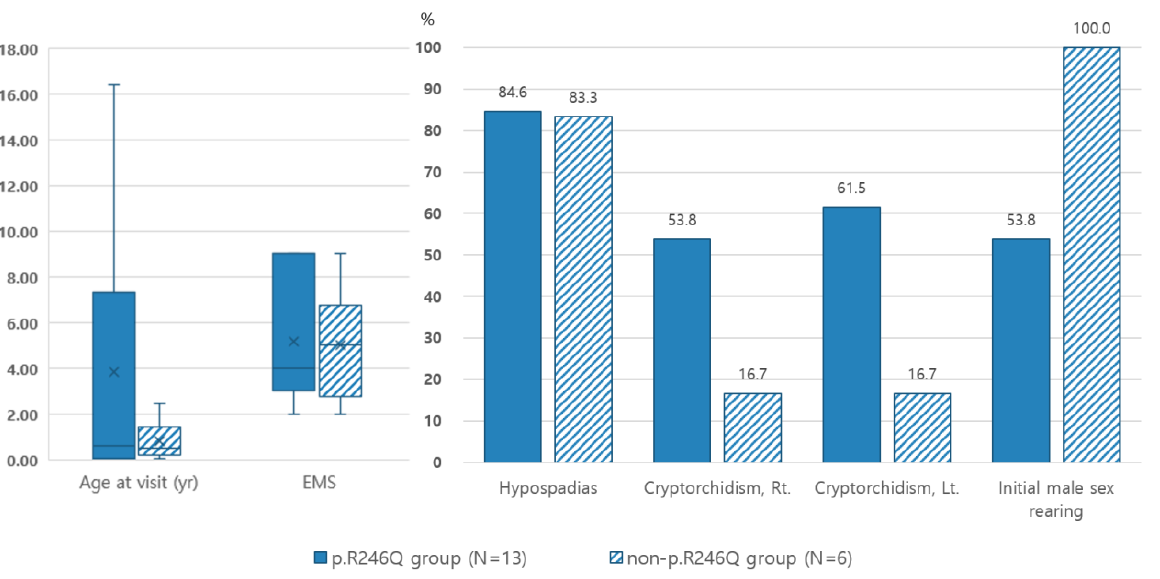
Figure 1. Clinical manifestations of 19 patients with or without the p.R227Q allele. × and horizontal line represented the mean and median values, respectively. • expressed outlier data.